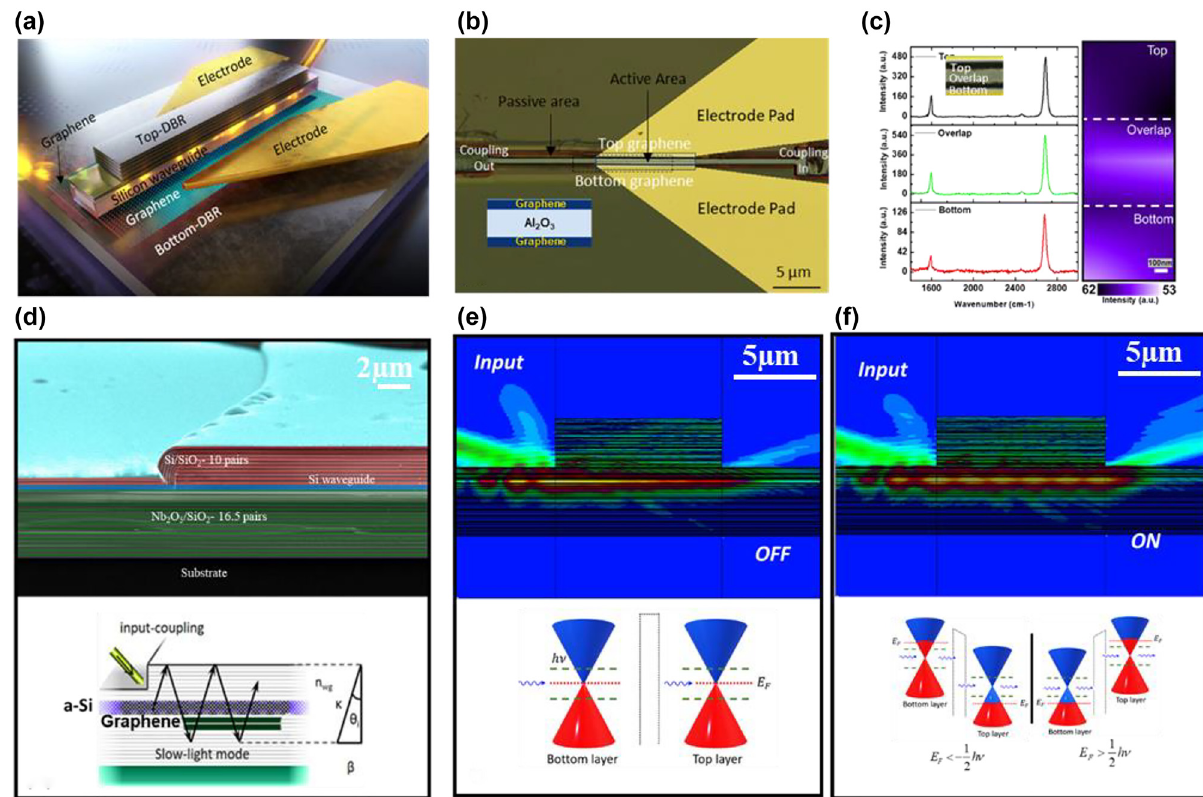
Figure 1: Bragg reflector waveguide integrated graphene optical modulator. (a) Three-dimensional schematic illustration of the ultra-high performance graphene optical modulator showing two layers of graphene are separated by interlayer of high- κ dielectric (Al 2 O 3 ) to form parallel-plate capacitor. Top and bottom DBRs lead to a constructive interference between the re fl ected beams. (b) Top view microscopicimage of the grapheneoptical modulator showingtop view of the waveguiding, input/ output couplers and electrode pads. (c) Raman mapping performed across channel showing intensity enhanced at the overlap region (microscope image as inset). (d(i)) Cross-section false-color SEM image of the fabricated graphene optical modulator, (d(ii)) electric fi eld distributions while excitation using a tilt-coupling scheme. (e) Light-emission direction in the modulating cavity. The top emission of the modulator is prohibited by plating a thin- fi lm dielectric re fl ectors, thereby light propagates to the modulator cavity in a zig-zag shape. EO modulatorwithun-dopedgraphenesheetsleadingFermilevelwouldbeat theDiracpointundertheilluminationof photonswith energyof ℏ ν . Inthiscase,thetransmissionwouldbeheavilyattenuated,andwecalleditasOFFstate.Graphene ’ sFermileveldistributionunderOFFstateis shown while the double layer graphene sheets are un-doped. Blue and red colors represent unoccupied and occupied states of Fermi level, respectively. (f) Electric fi eld distribution in EO modulator with graphene ’ s heavily hole or electron doped, which the state is called ON state; whereby inter-band transition is heavily suppressed, and transmission